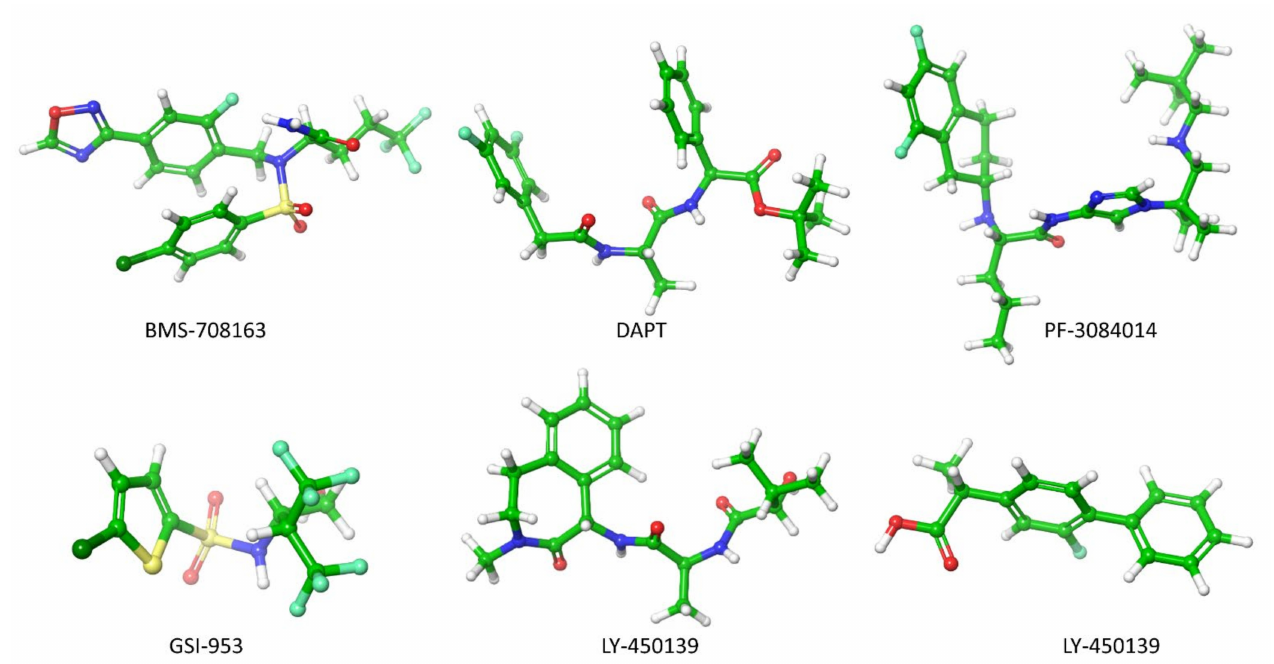
Figure 5. The γ -secretase inhibitors used in clinical trial for the treatment of AD and taken from